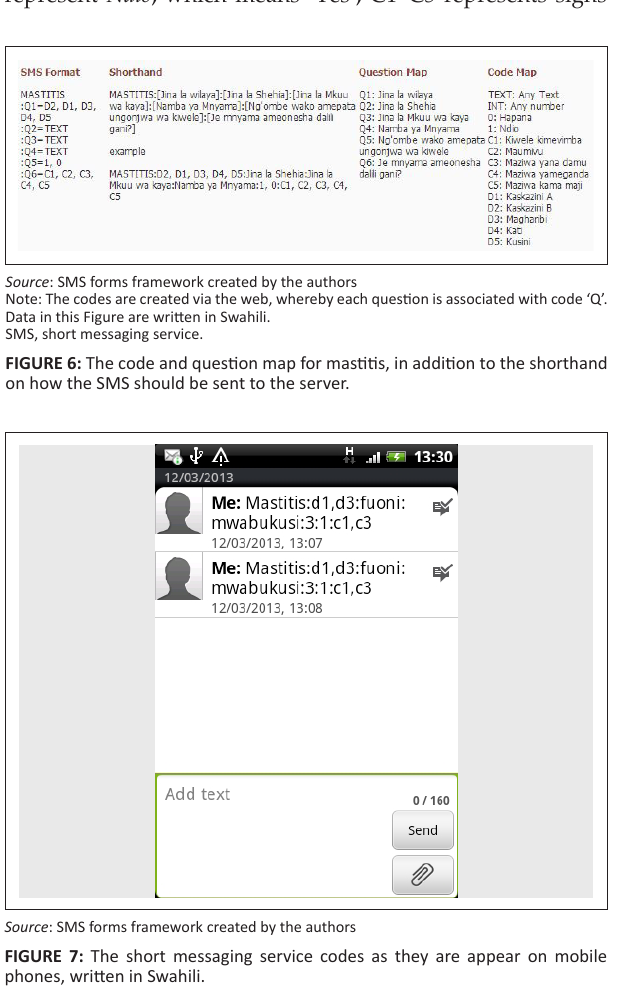
FIGURE 5: Digital form data submitted by Flora Patta, a livestock field officer in Endulen village in Ngorongoro district, Tanzania.